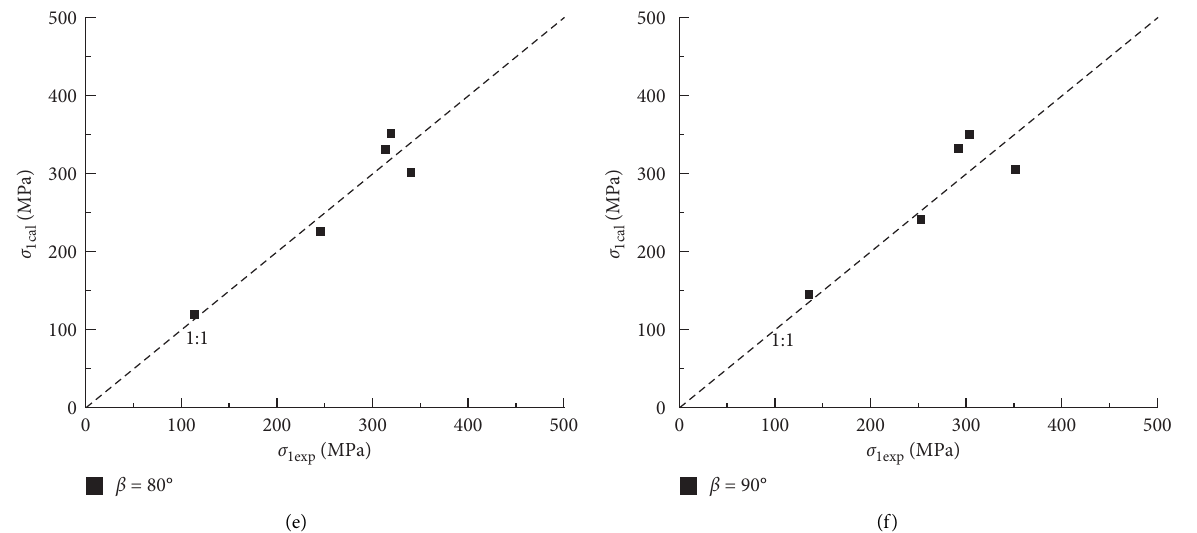
Figure 4: The comparison results of the calculated and experimental strength of jointed marble for different joint inclination angles: (a–f) β � 0 ° , 20 ° , 40 ° , 60 ° , 80 ° , and 90 ° .